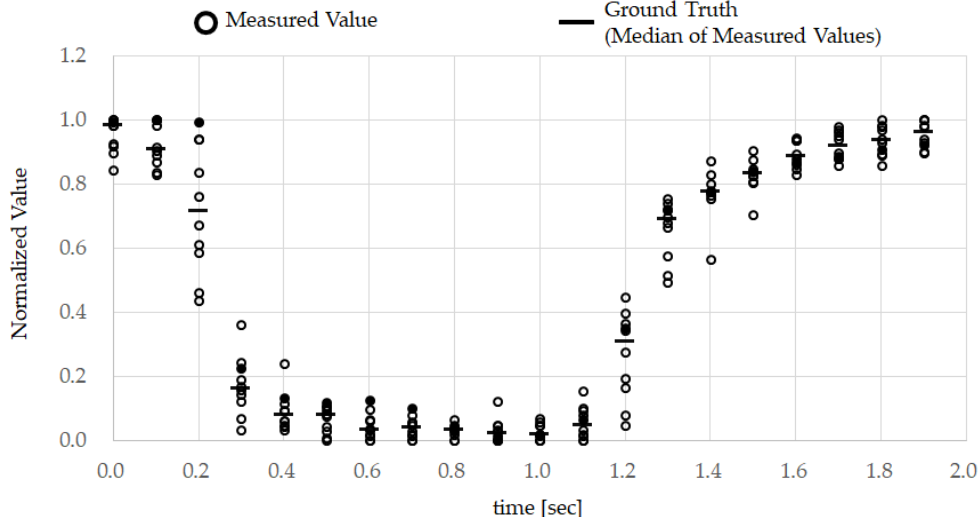
Figure 5. Ground truth obtained from subject A: the subject repeated TEMPO ten times, while the movement of the external acoustic meatus was measured by the earphone-type sensor. The obtained data was normalized, and the median values from the normalized data from each time were extracted and used as the ground truth as described in Section 3.2.